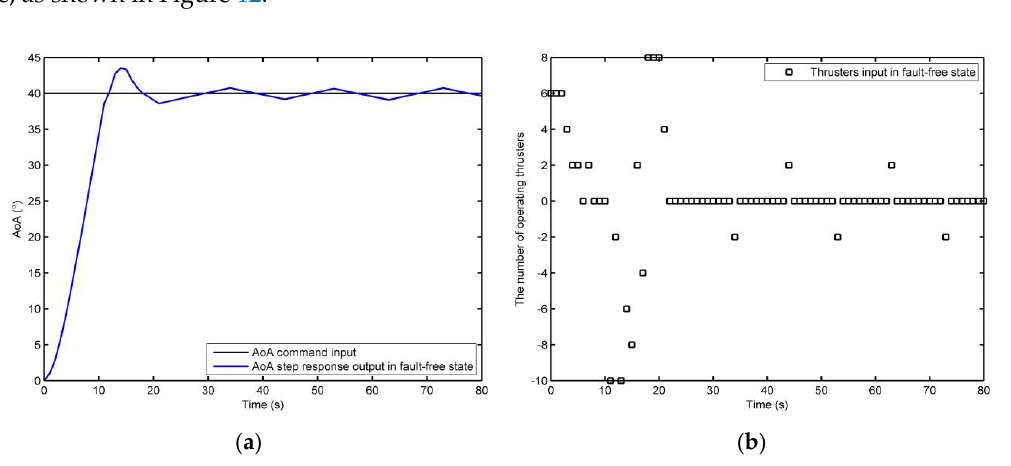
Algorithms 2019 , 12 , x FOR PEER REVIEW 16 of 21 Table 2. Fault detection rates test. Fault Type Fault Number Miss Ratio P M (%) EKF Solution/ Blending Filter Solution 89.40/96.20 Based on the classification of class A, B, and C faults, it was easy to distinguish the fault classed based on the state of the control input of class A faults which is different from that of class B and C faults. The class B and C faults produced different thrust so the